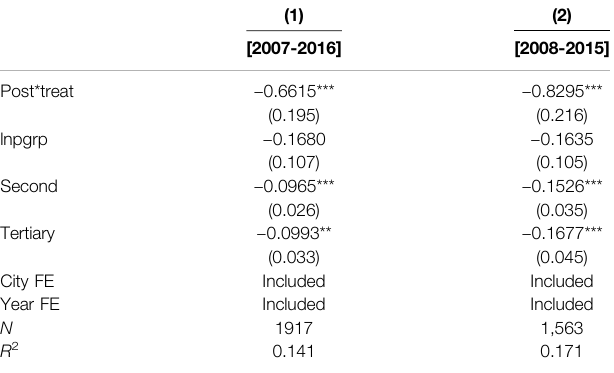
TABLE 8 | Robustness test (reset the research